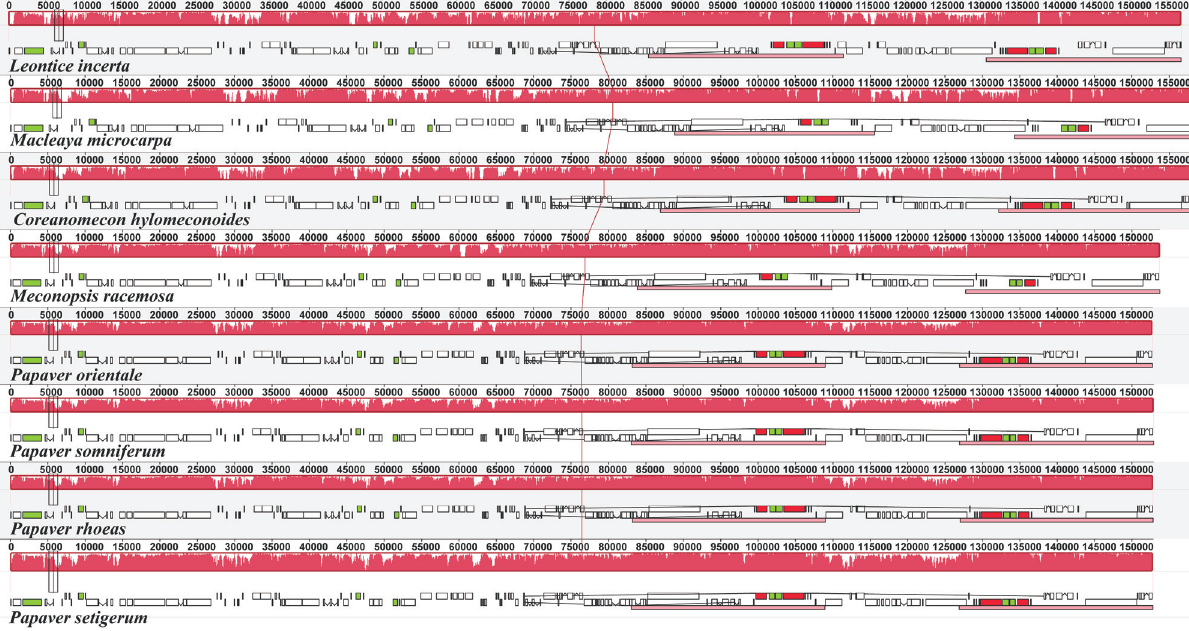
Figure3 -MAUVEalignmentofsevenPapaveraceaechloroplastgenomes. Leonticeincerta isshownatthetopasthereference.Withineachofthealign- ments, local collinear blocks are represented by blocks of the same color connected by